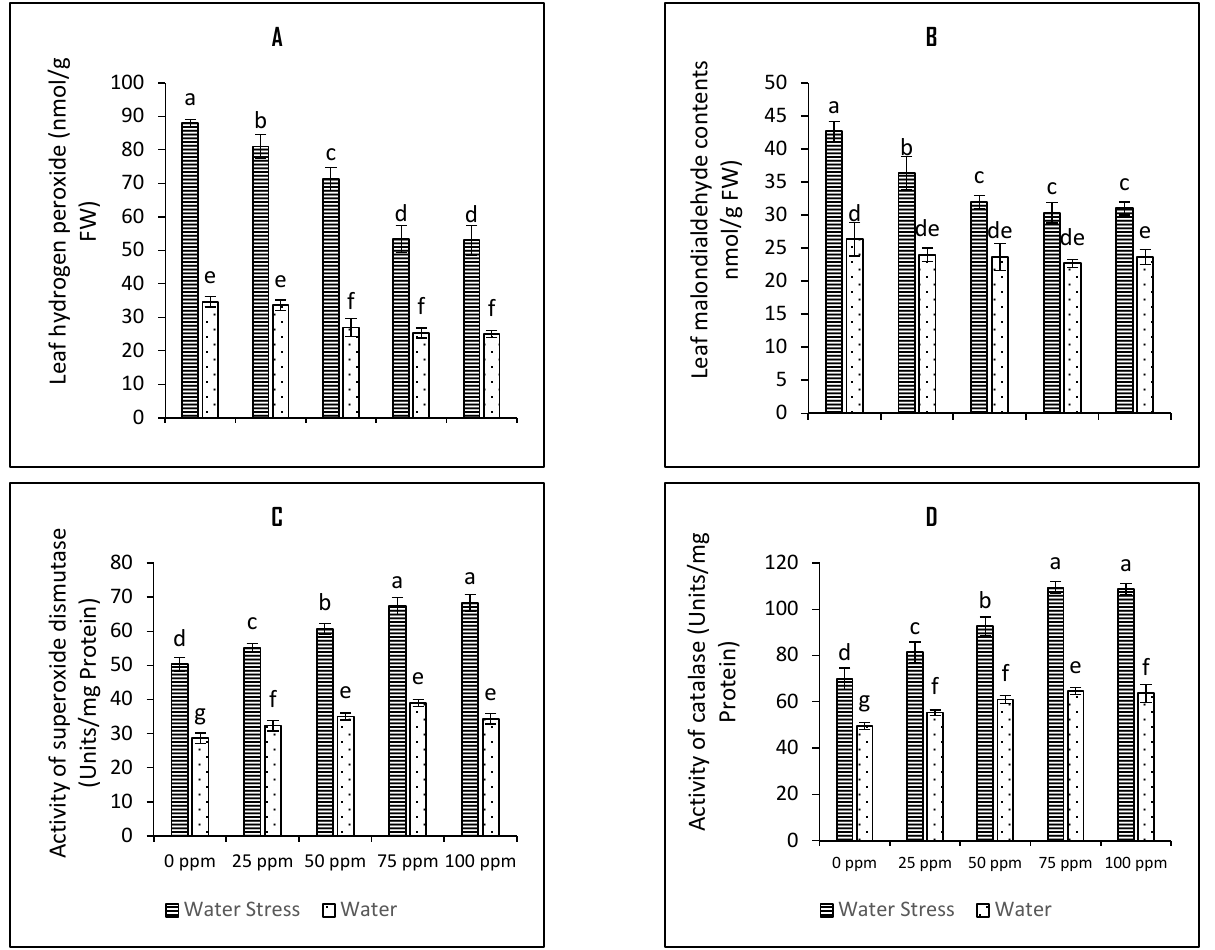
Figure 2. Bar charts (mean ± S.E; n = 3) representing levels of osmotic stress markers ( A ) leaf hydrogen peroxide contents and ( B ) leaf malondialdehyde contents and functioning of antioxidant enzymes ( C ) superoxide dismutase activity and ( D ) catalase activity in tomato plants raised from SeNPs-primed seeds grown under water stress and water conditions. 0, 25, 50, 75, and 100 ppm on x -axis represent concentrations of Se-NPs followed in the seed-priming experiment. Bars with different alphabets represents mean data which significantly differs at ( p <